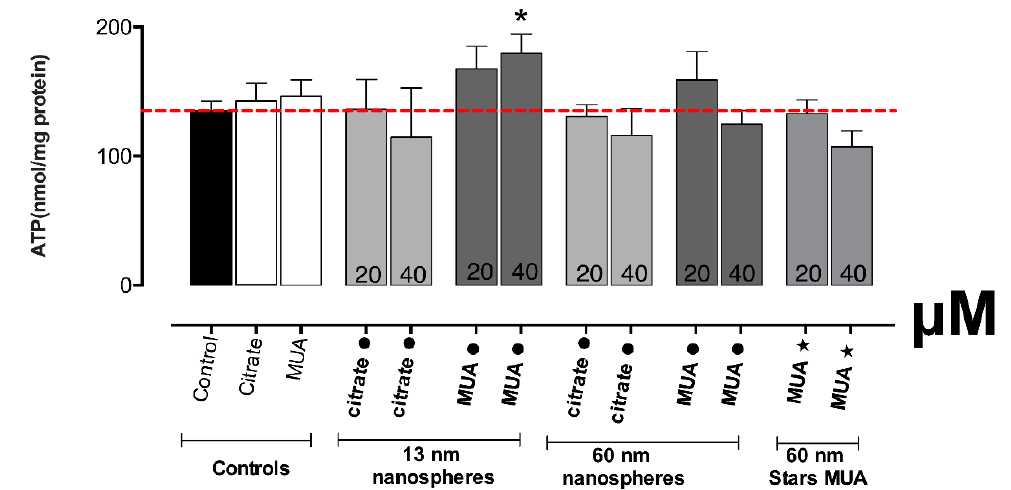
Figure 5. Intracellular ATP levels, in HK-2 cells, after 24 h incubations at 37 °C with AuNPs. Results from three independent experiments are expressed as mean ± standard error of the mean (SEM). Statistical comparisons were made using Kruskal – Wallis one-way analysis of variance/ Dunnett’s post hoc test. * p ≤ 0.05; versus control.